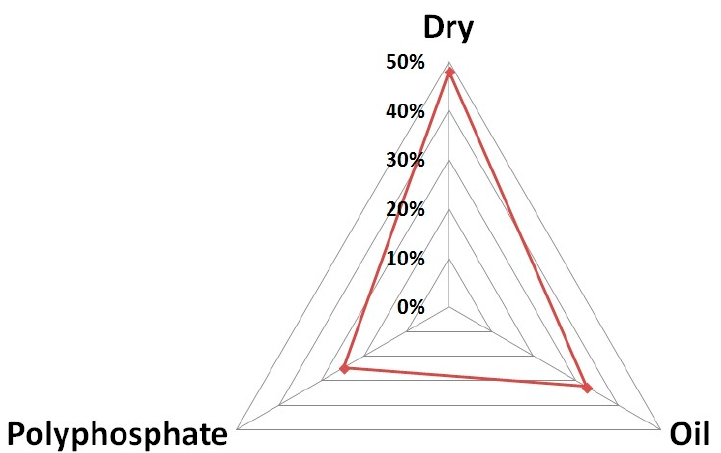
Figure 9. Fraction of grains in the detected area (1.2 × 0.9 mm 2 ) containing in-grain shear bands for different lubricants at 700 °C.